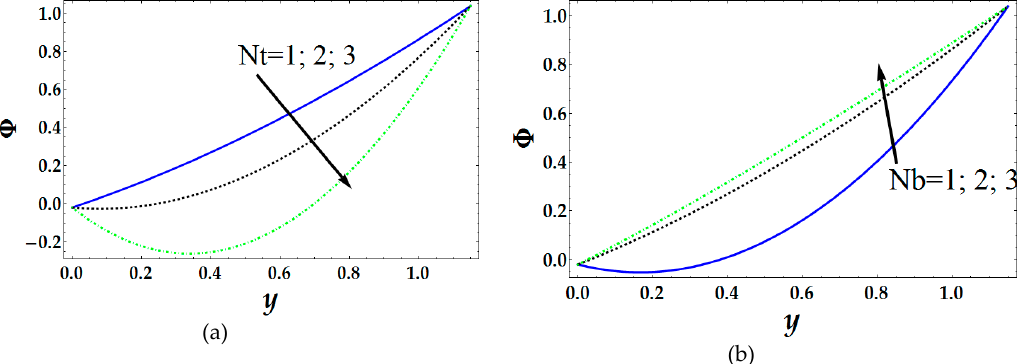
Figure 3. Concentration profile for various values of 𝑁 (cid:3047) and 𝑁 (cid:3029) .